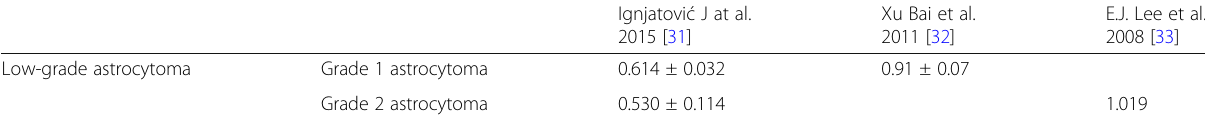
Table 8 The glial malignancy mean ADC values reported in the literature ×(10 − 3 mm 2